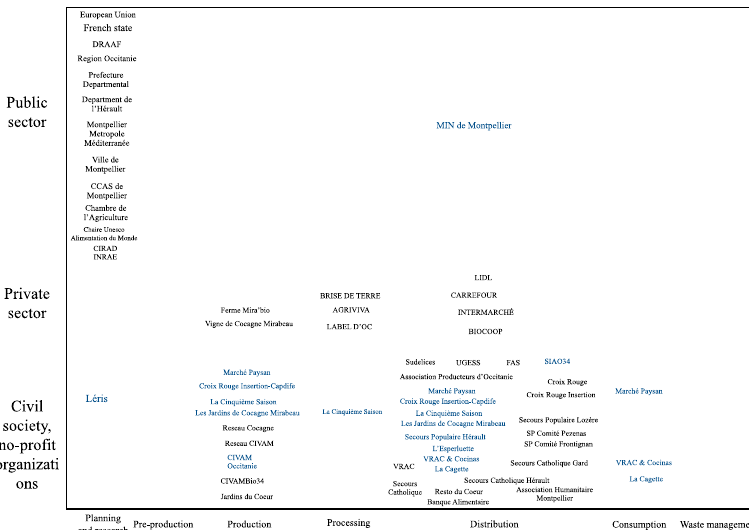
Figure 4. All the 54 actors